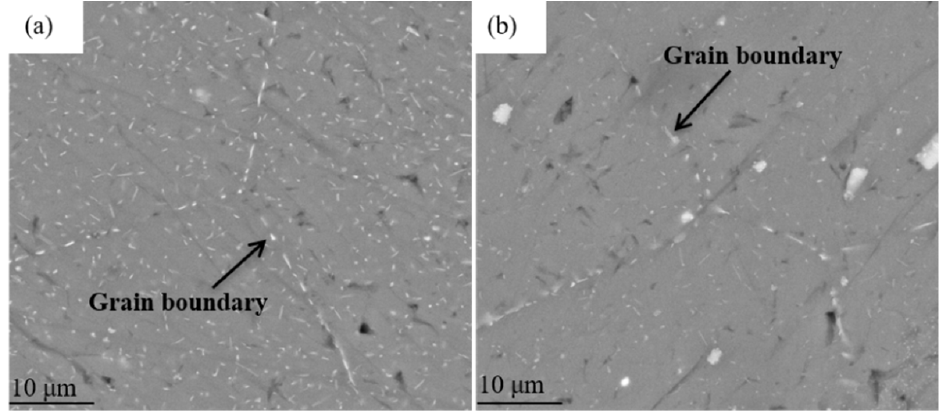
Figure 2. SEM images of the samples under DA and 295 °C isothermal treatments: ( a , b ) DA; ( c , d ) 100 s; ( e , f ) 800 s; ( g , h ) 1500 s.